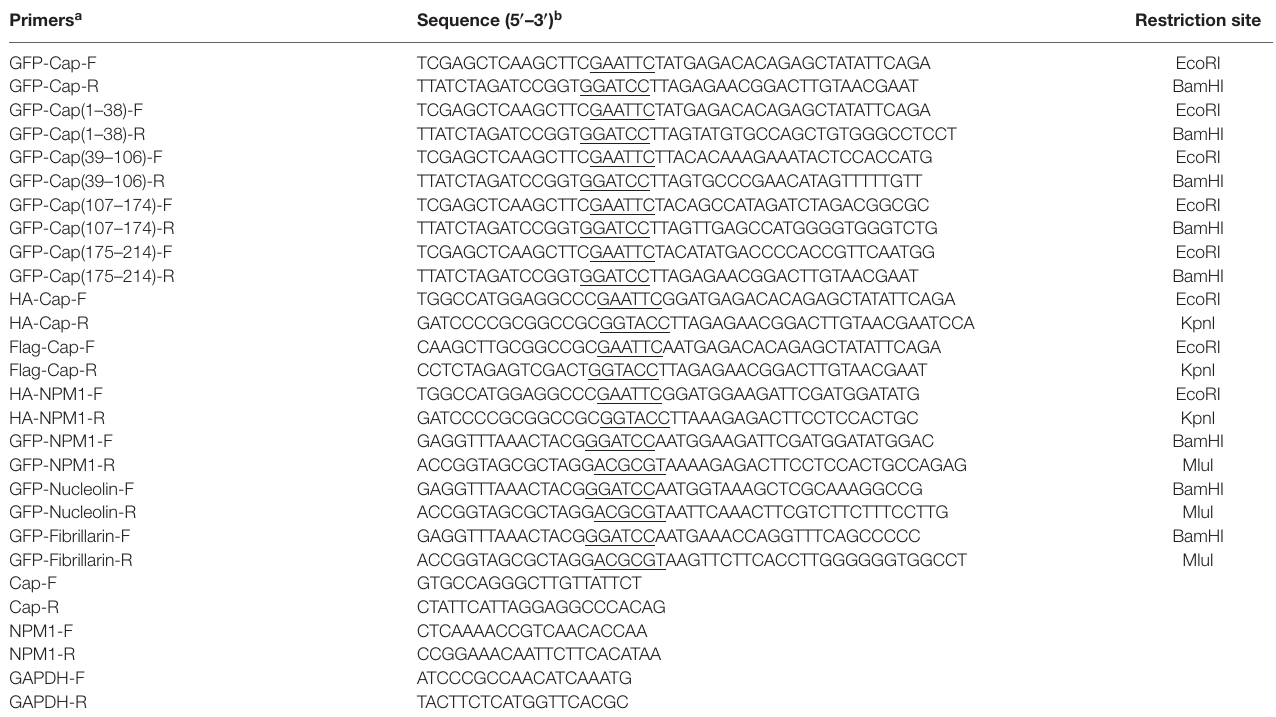
TABLE 1 | Primers used in this study. Primers a Sequence (5 (cid:48) –3 (cid:48) )